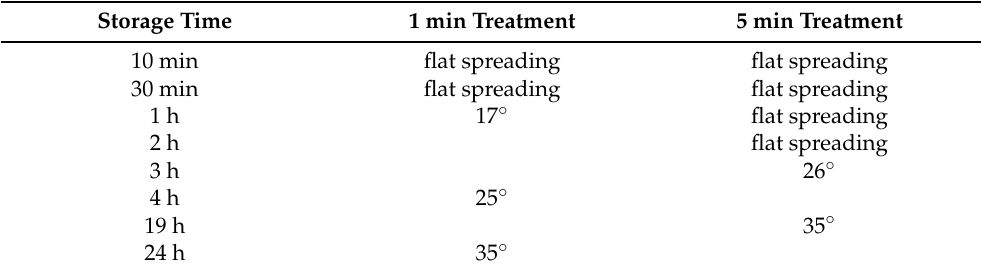
Table 3. Hydrophobic recovery: Influence of the storage time on the contact angle.